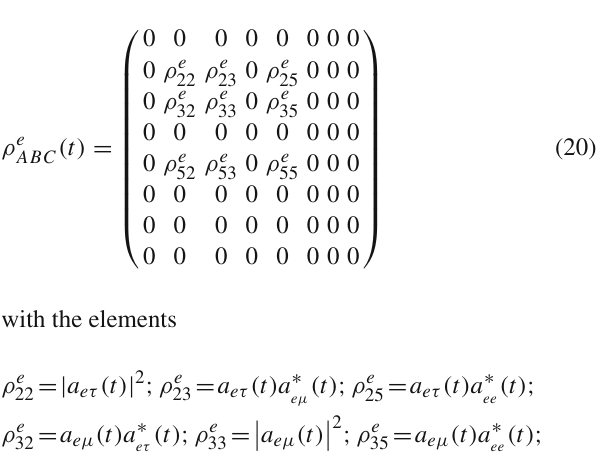
the experimental results and corresponding theoretical pre- dictions of survival probabilities ν e → ν e are plotted with the respect to the ratio L / E with the dimension km/MeV in Fig. 1, where EH1, EH2 and EH3 are the data addressed from Daya Bay collaboration for three different experimental halls [3]. It is obvious that Fig. 1 shows a concave curve. Explic- itly, one can observe that the survival probability P ee first decreases and subsequently increases, and comes to the min- imum at around L / E = 0 . 5 km/MeV. Notably, the survival